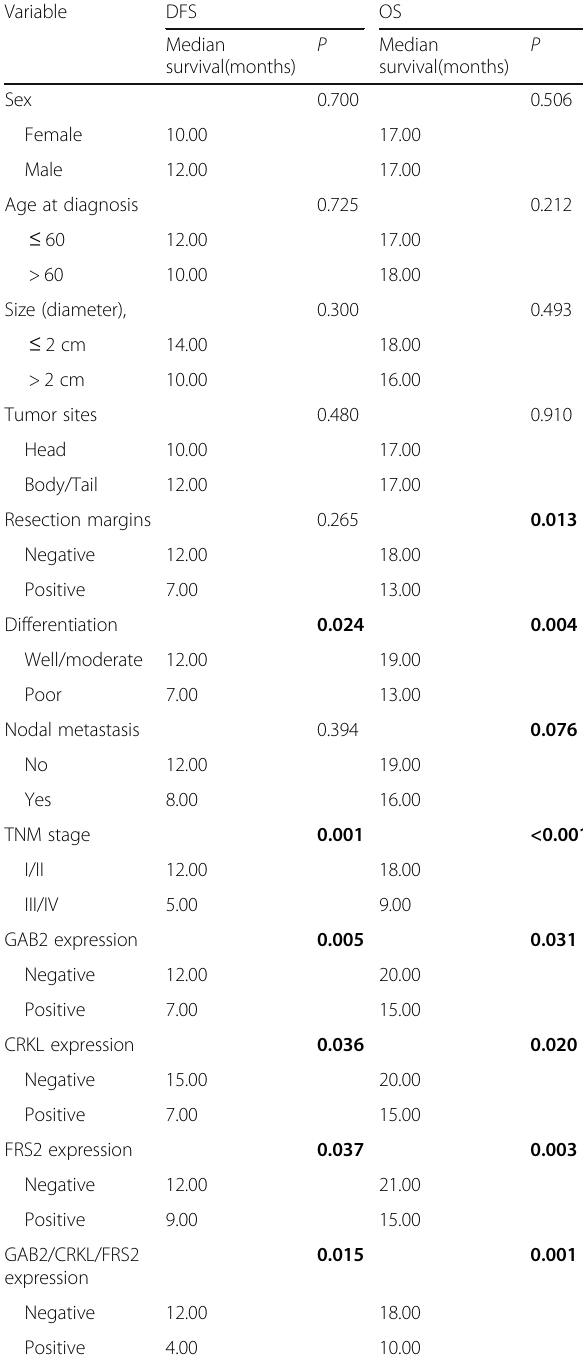
Table 3 Univariate analyses for DFS and OS